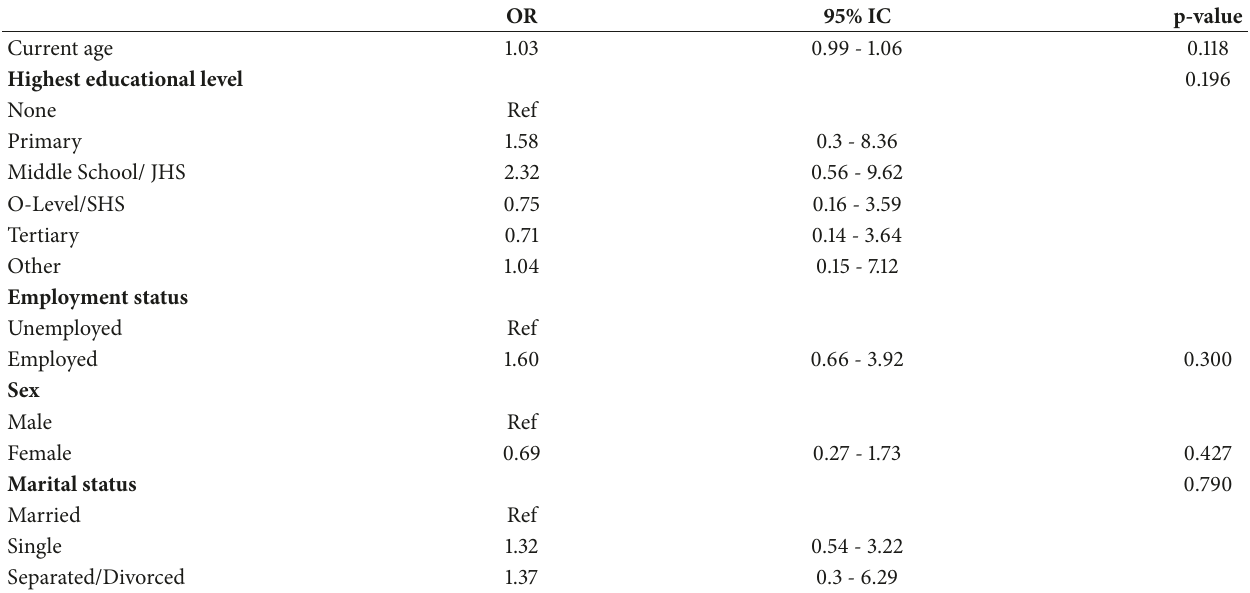
Table 4: Effects of sociodemographic factors on 2HPP status (model six).